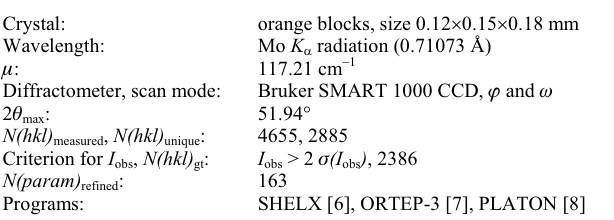
Table 1. Data collection and handling.